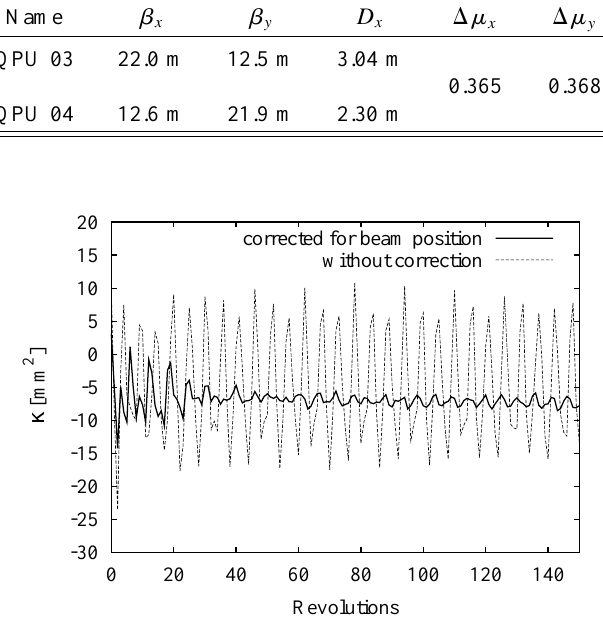
FIG. 2. Quadrupole moment k measured with a PS pickup im- mediately after injection, with and without correction for beam position. The initial beam-size oscillation is clearly visible in the corrected signal. Note the fast decoherence of beam-size oscillations, due to direct space